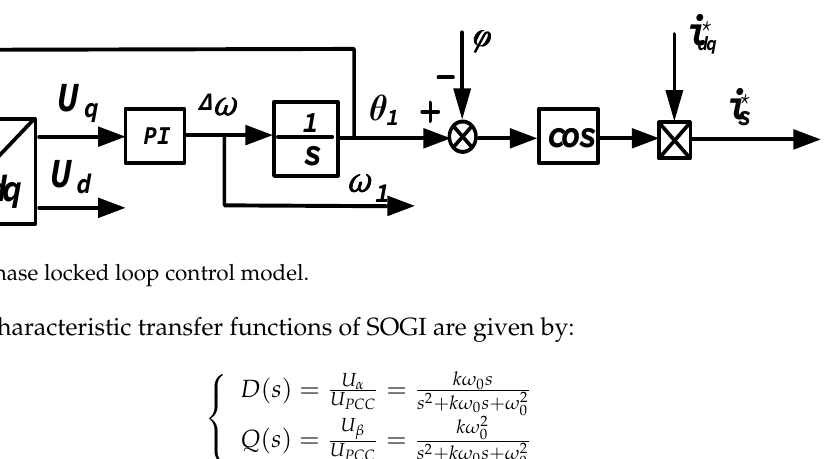
Figure 4, the AC voltage component with phase lag of 90 ◦ at the U PCC is generated by the OSG (Orthogonal Signal Generators) module. The orthogonal signals U α and U β are transformed into the voltages U d and U q in the rotating frame system [20].